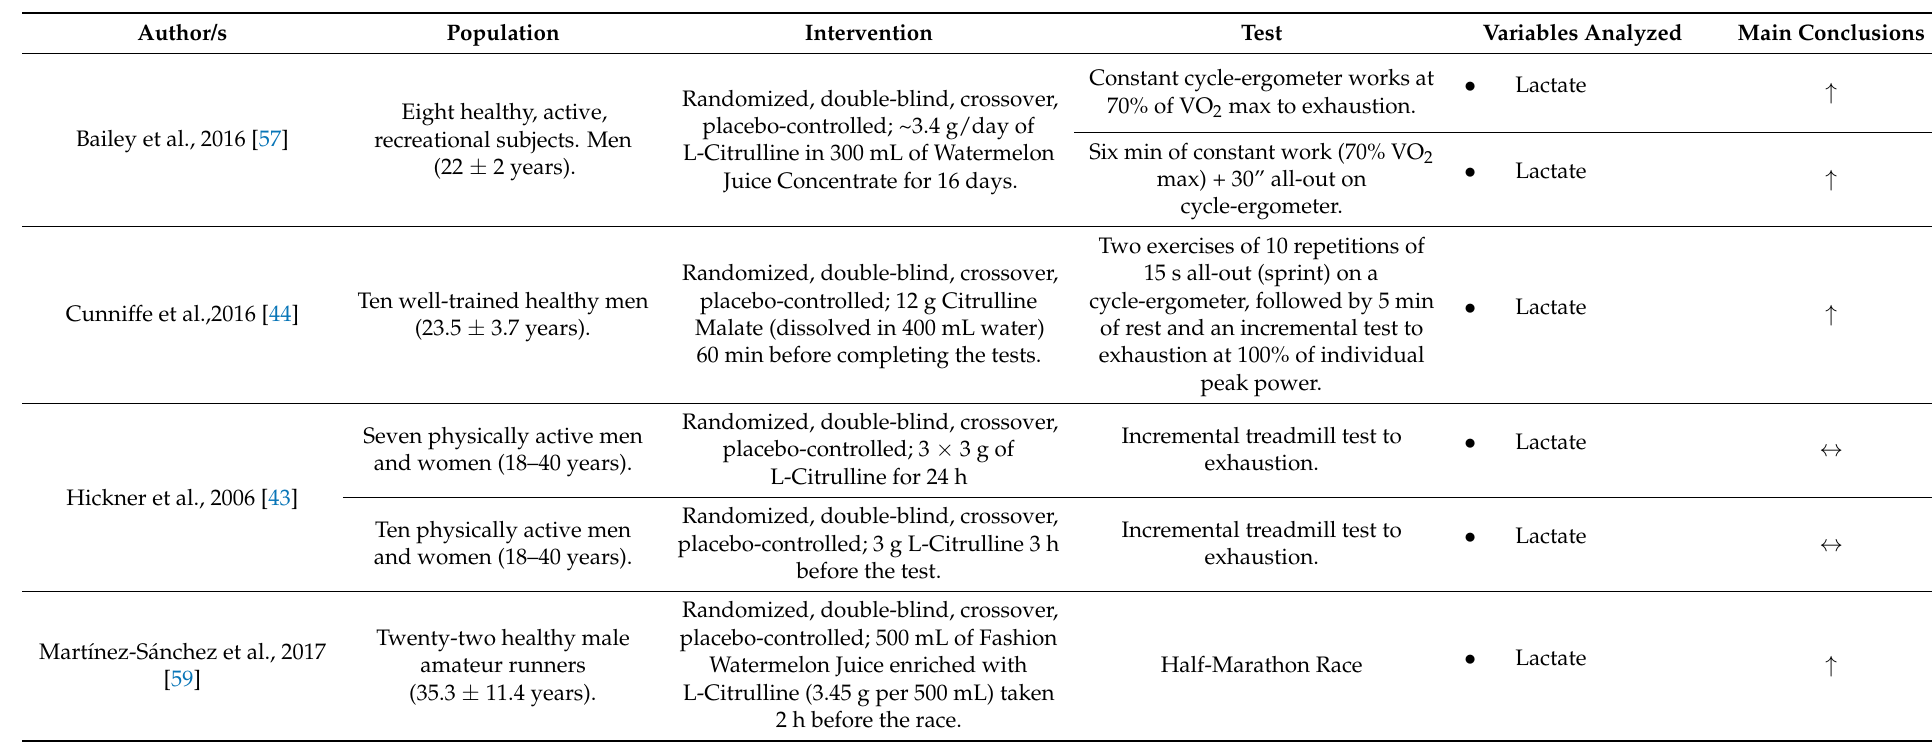
Table 5. Summary of studies included in the systematic review and meta-analysis investigating the effect of Cit on